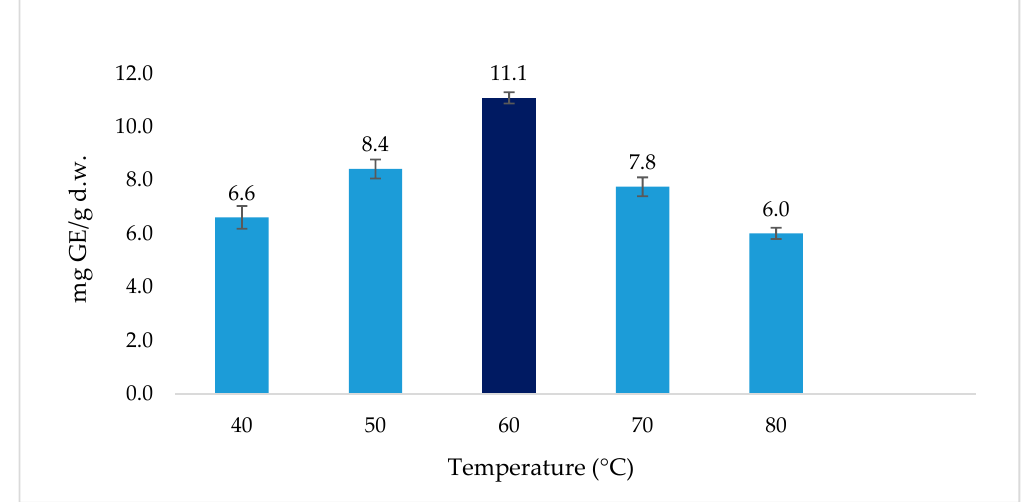
Figure 3. Effect of extraction temperature.